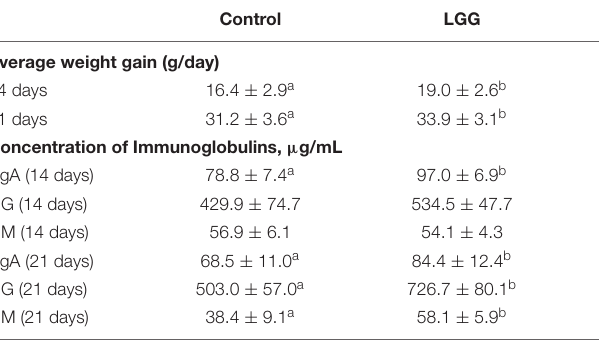
TABLE 3 | Effects of dietary LGG on body weight and immunoglobulins in chickens.